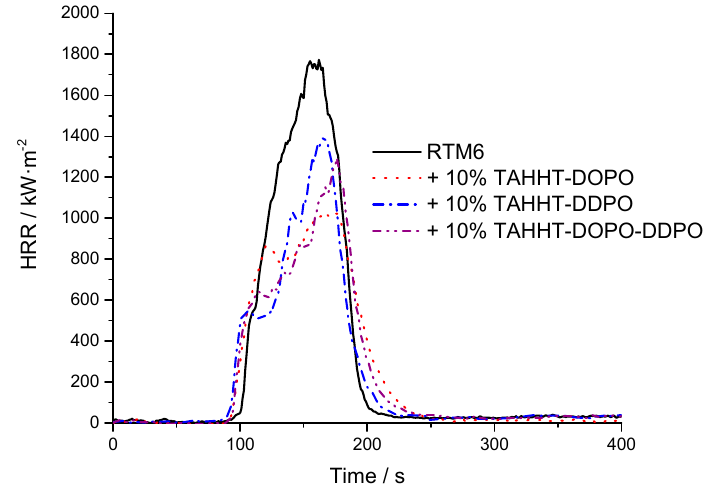
Figure 6. Heat release rate (HRR) of non-reinforced samples at 35 kW·m − 2 .